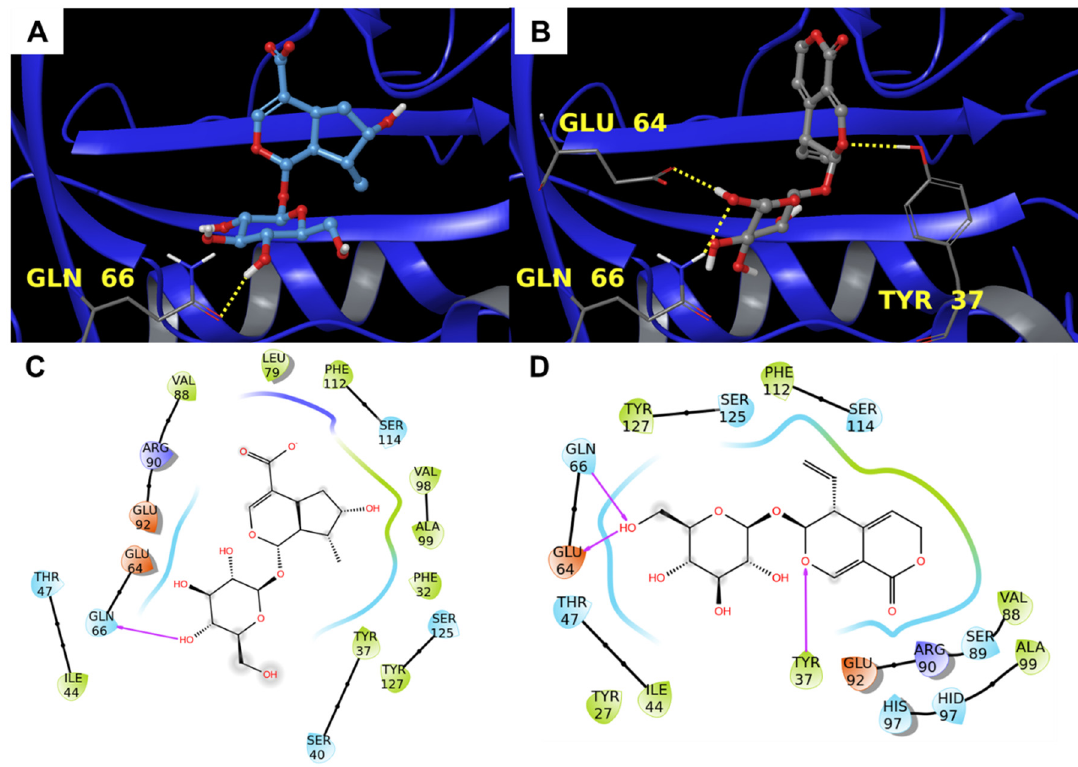
Figure 7. Molecular docking results. ( A , B ) 3D binding mode of 1 ( A ) and 2 ( B ) with alpha-1-acid glycoprotein (PDB: 3APW [47], blue ribbons). Hydrogen bonds are represented by yellow dotted lines. ( C , D ) 2D representation of the binding pose of 1 ( C ) and 2 ( D ). Pink arrows represent hydrogen bonds.